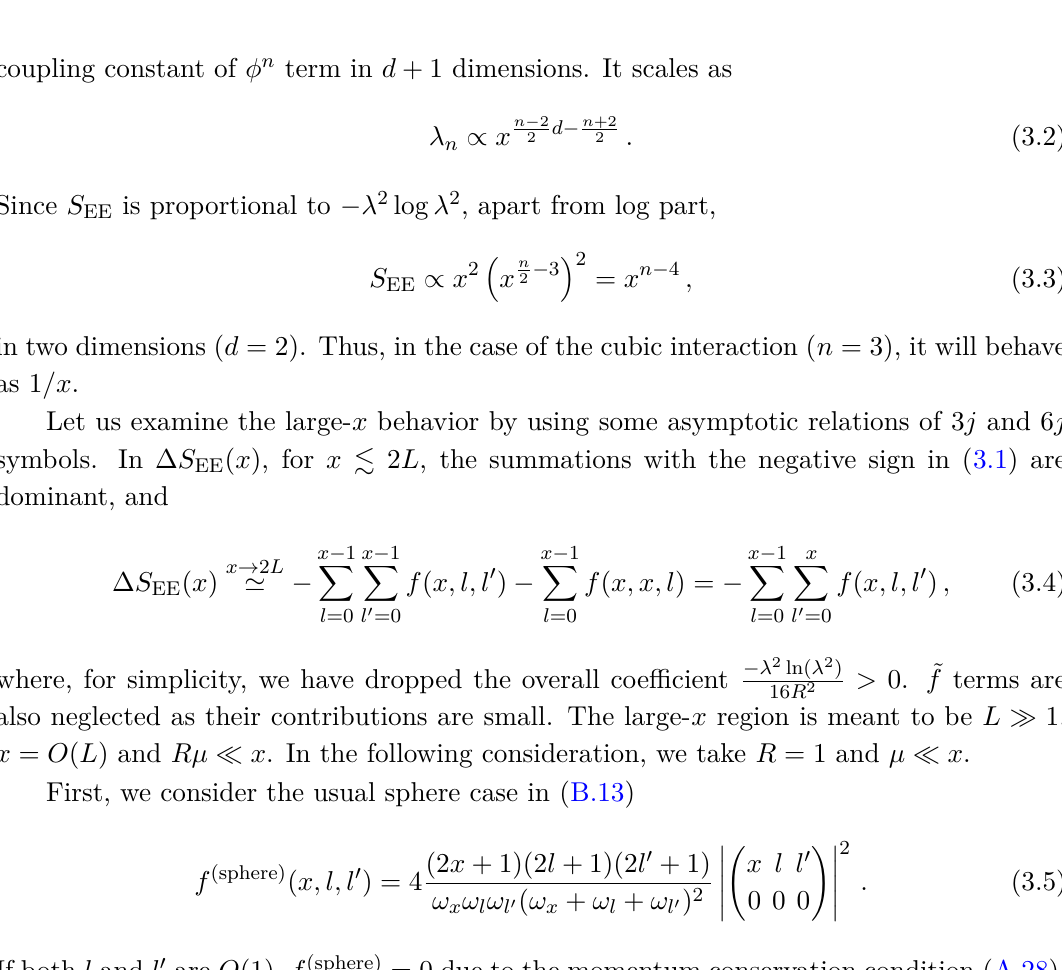
Figure 5 . Two typical examples of the derivative of the EE of the fuzzy sphere ∆ S EE ( x ) (up to − λ 2 ln λ 2 / 16 R 2 ). The horizontal axis is x . R = 1 and L = 50 . µ = 10 and µ = 15 cases are